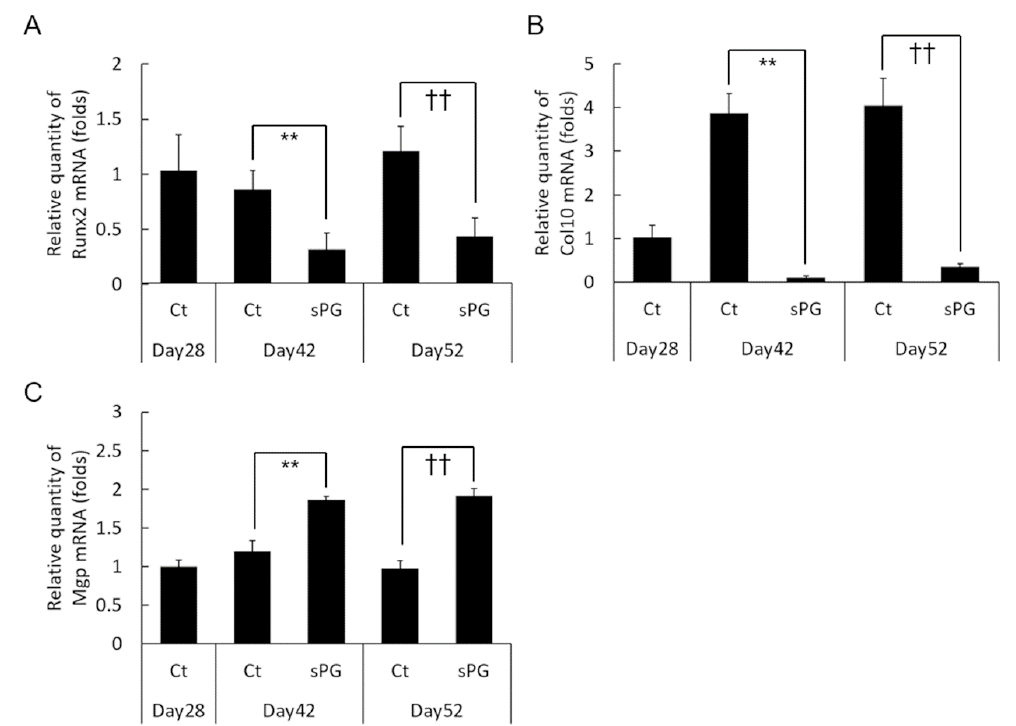
Figure 7. Effects of sPG on cartilage calcification factors in ATDC5 cells. Real ‐ time quantitative PCR analysis of mRNA expression on calcification ‐ related factors, Runx2 , Col10a1 and Mgp . Untreated